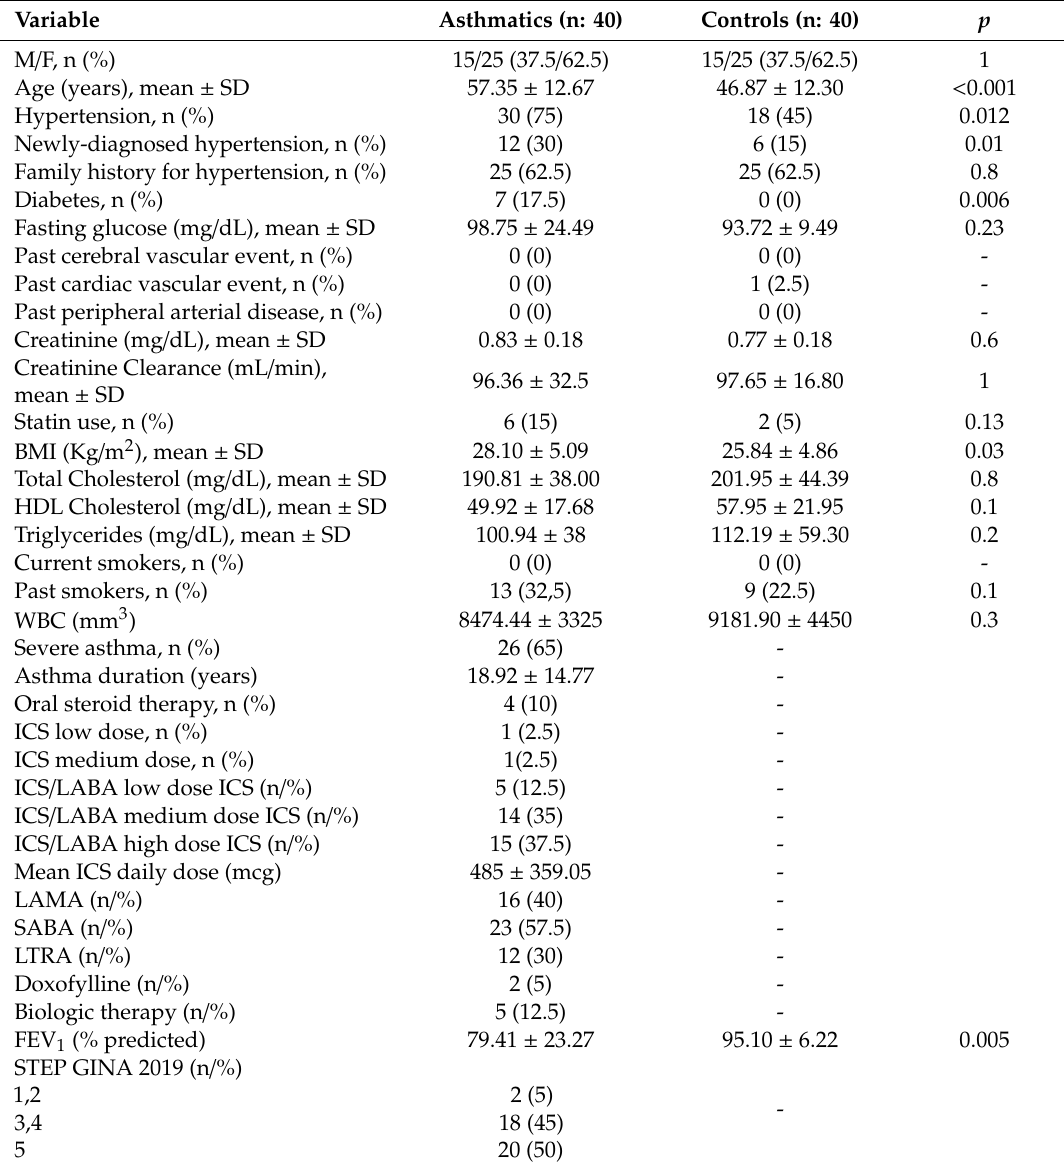
Table 1. Demographic, clinic and lab variables—asthmatics vs.